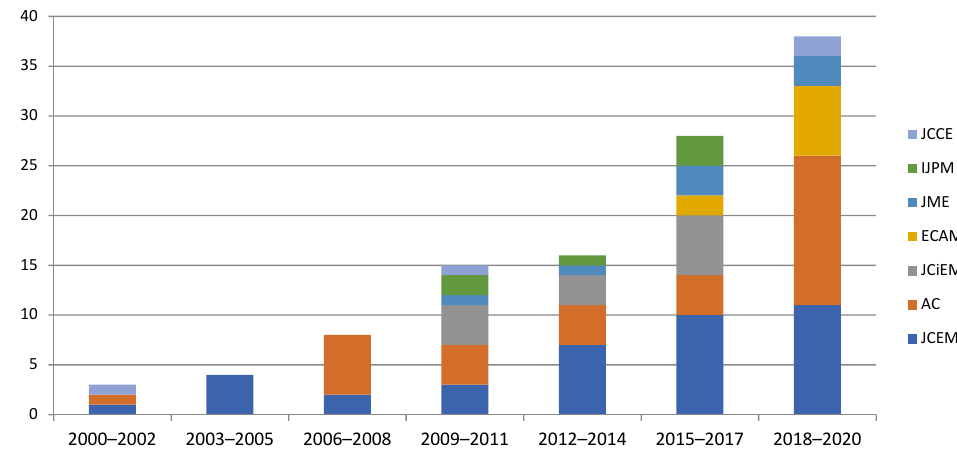
Figure 3. Publication trend of literatures on ANN in CM (2000–2020).